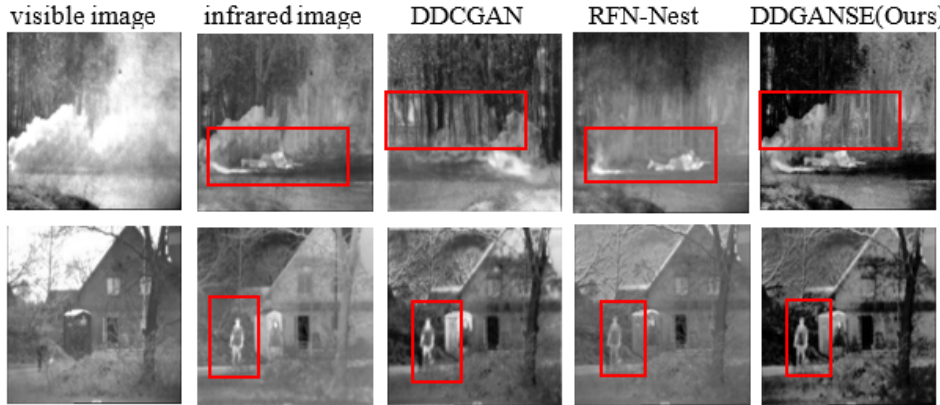
Figure 7. Comparison of the contrast between target information and background information in the experimental results. From left to right: visible images, infrared images, and fused results obtained with DDCGAN, RFN-Nest, and DDGANSE (ours).